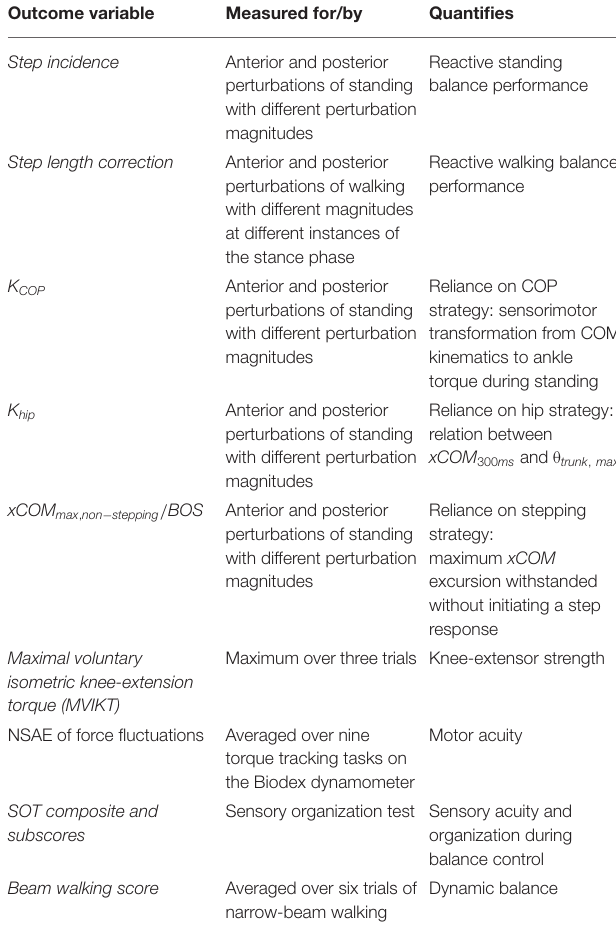
TABLE 1 | Description of outcome